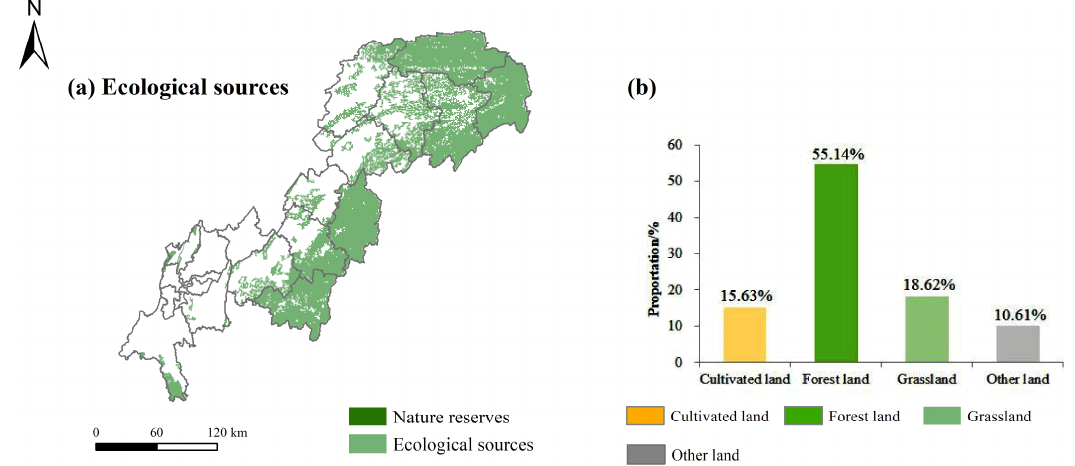
Figure 6. Spatial distribution of ecological sources ( a ), and composition of land use types in the ecological sources ( b ).